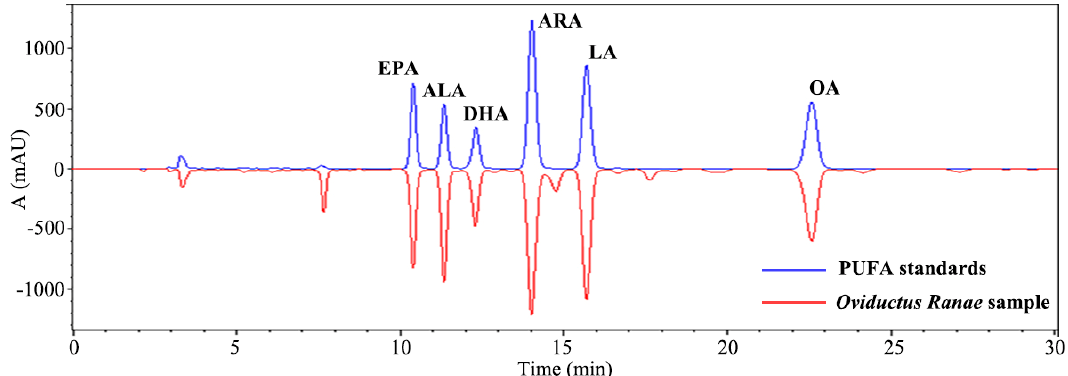
Figure 3. Comparison of PUFAs mixed standard with petroleum ether extract of Oviductus Ranae. Eicosapentaenoic acid (EPA), α -linolenic acid (ALA), Docosahexaenoic Acid (DHA), arachidonic acid (ARA), linoleic acid (LA), oleic acid (OA), polyunsaturated fatty acid (PUFA).